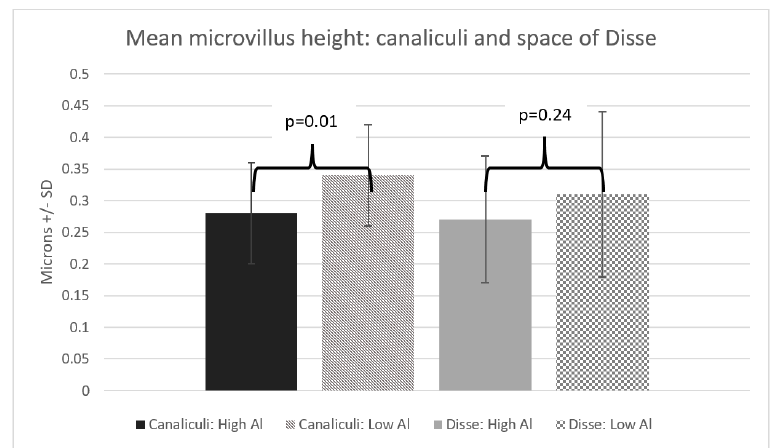
Table 1. Characteristics of the study population and ANOVA analysis.